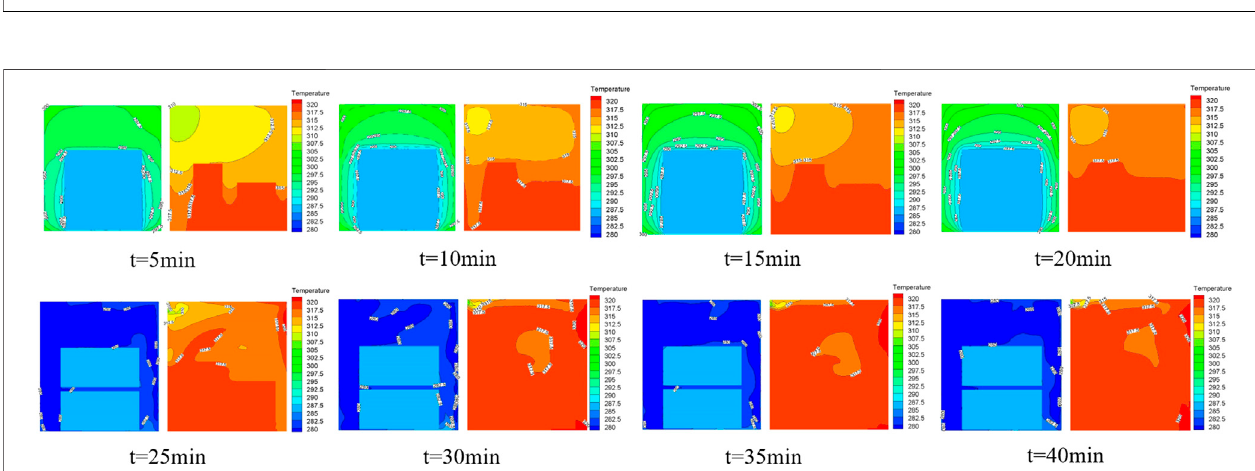
FIGURE 9 | The variation of dual zone temperatures and cargo temperatures with time.